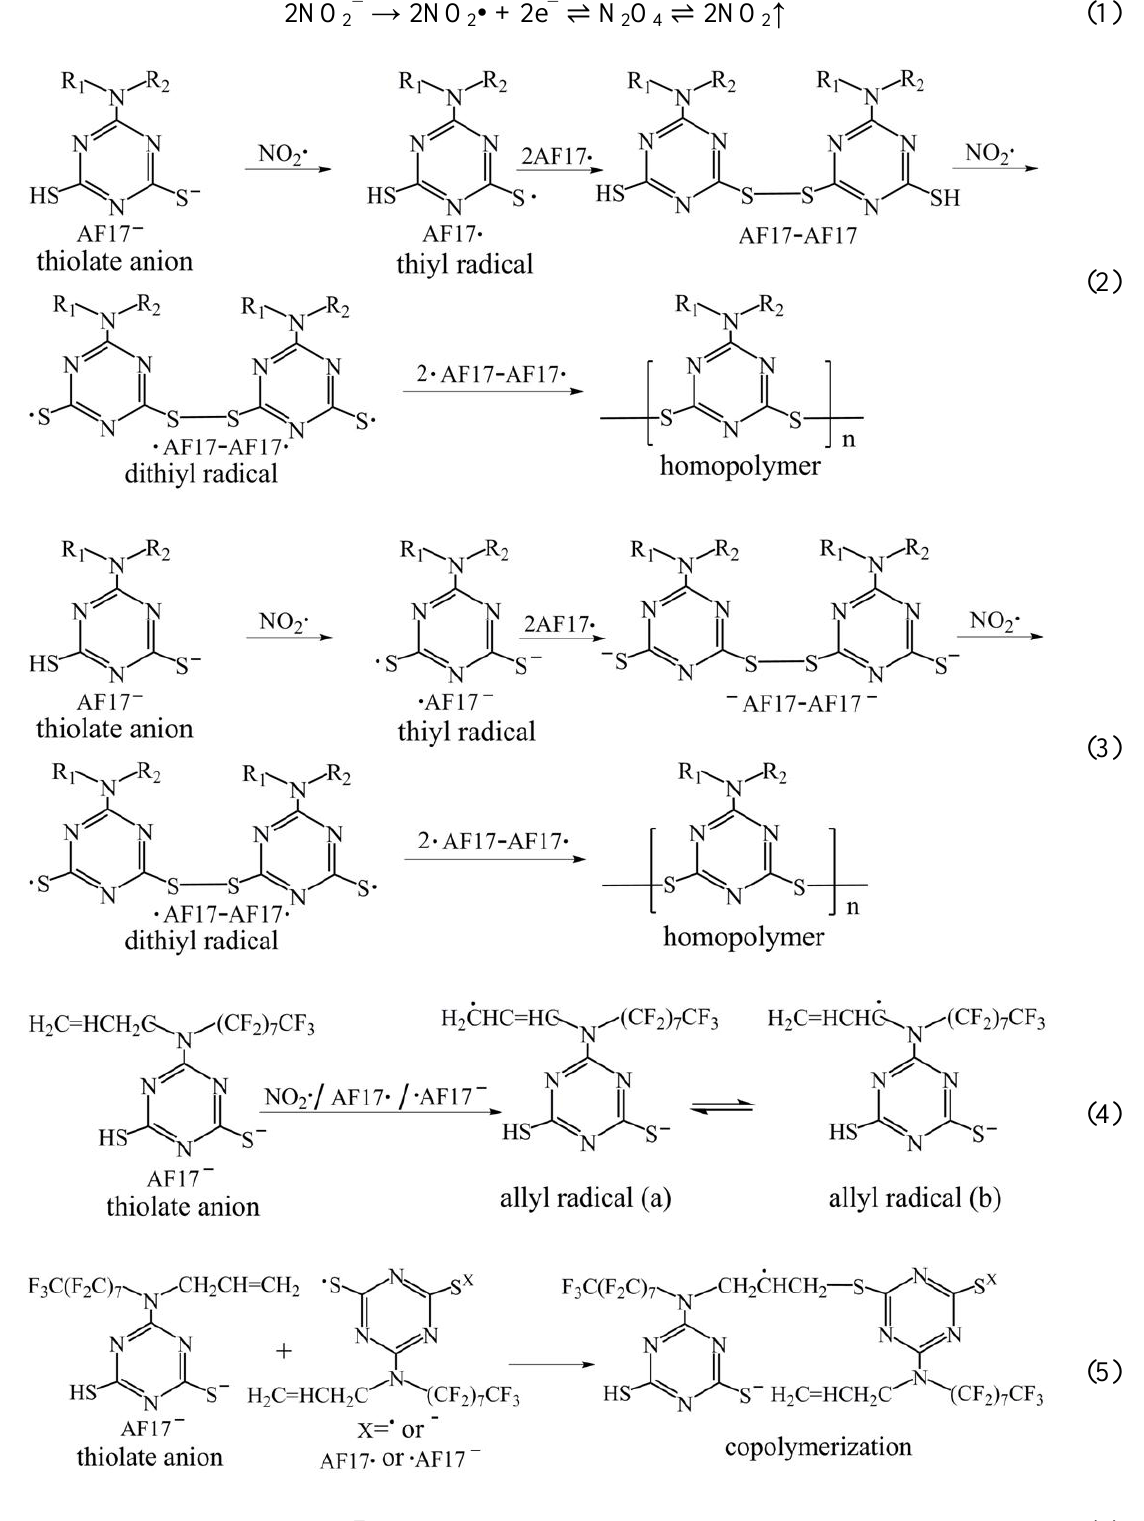
Scheme 1. Radical mechanism for the formation of PAF17 nanofilms on aluminum surface in the aqueous solution of AF17N and NaNO 2